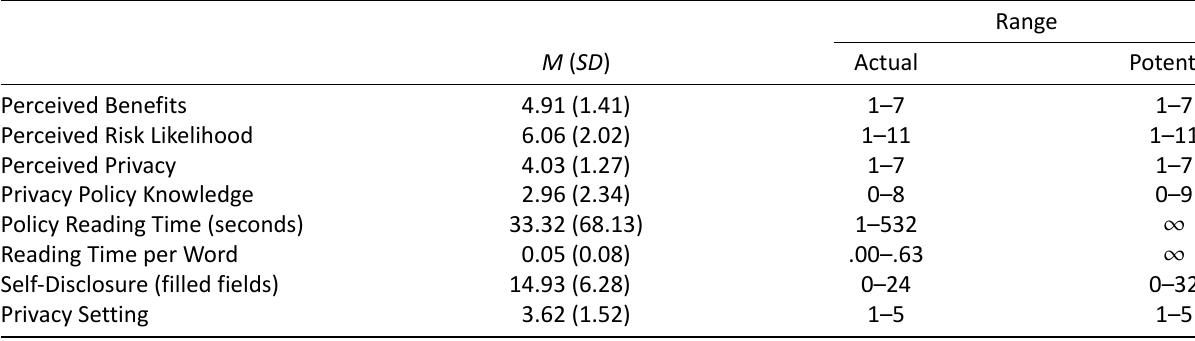
Table 2. Descriptive statistics of the assessed constructs and behavioral data.